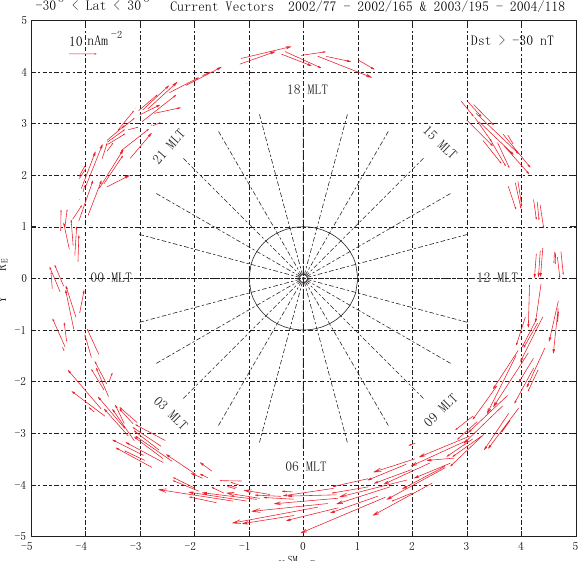
Fig. 4. The distributions of ring current around the equator plane in SM coordinates around Cluster perigee crossings between 18 March 2002 (77/2002, orbit number 265) and 14 June 2002 (165/2002, orbit number 302) and between 14 July 2003 (195/2003) and 27 April 2004 (118/2004). The vectors represent the directions and magnitude of the current density in XY